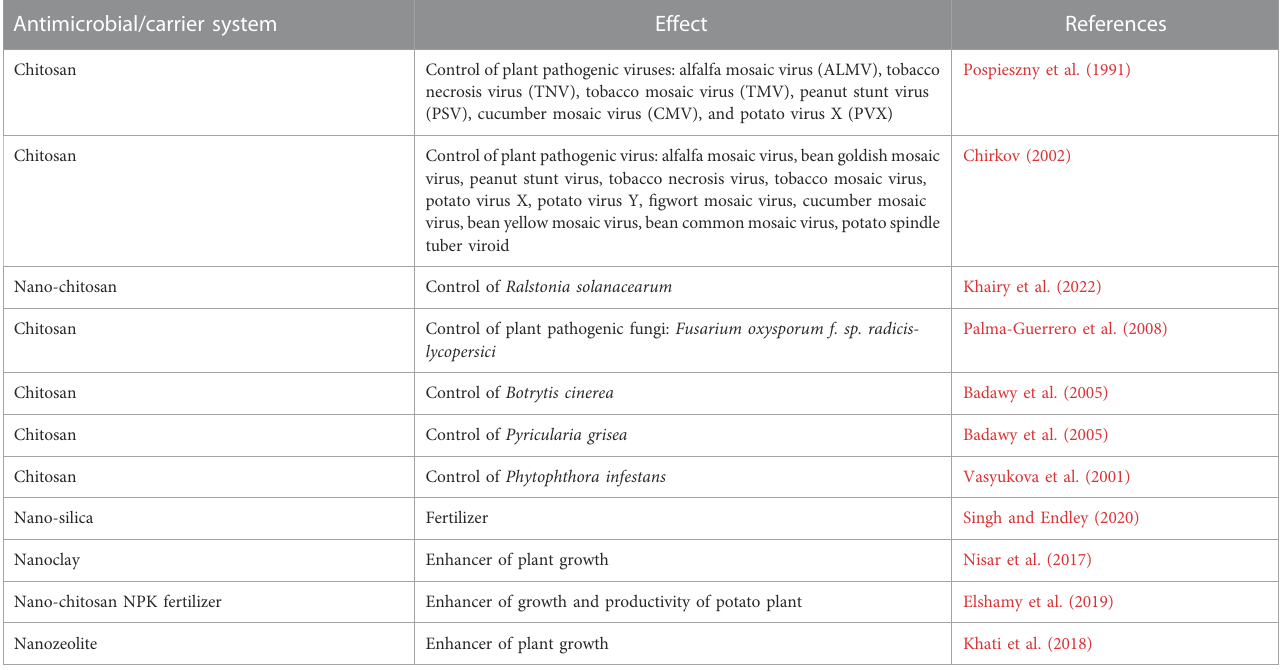
TABLE 1 Carrier systems and antimicrobials with the potential to be used as carriers for molecules or active ingredients for plant production. Antimicrobial/carrier